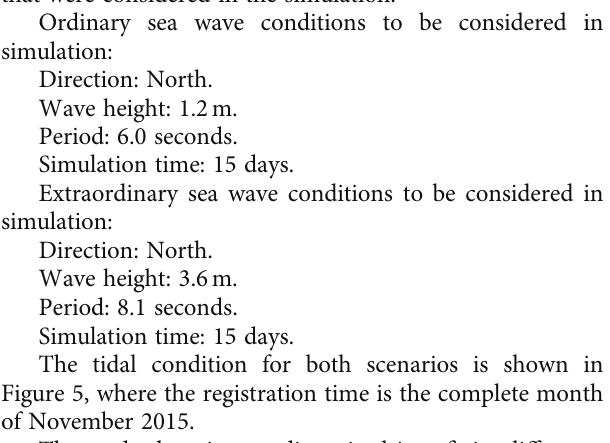
Figure 10: Fluctuation of the free-surface at the control point 1, 3, and 5 in roadless simulation extraordinary Table 2: Maximum wave height referred to below mean low water level for control point 1, 3, and 5.